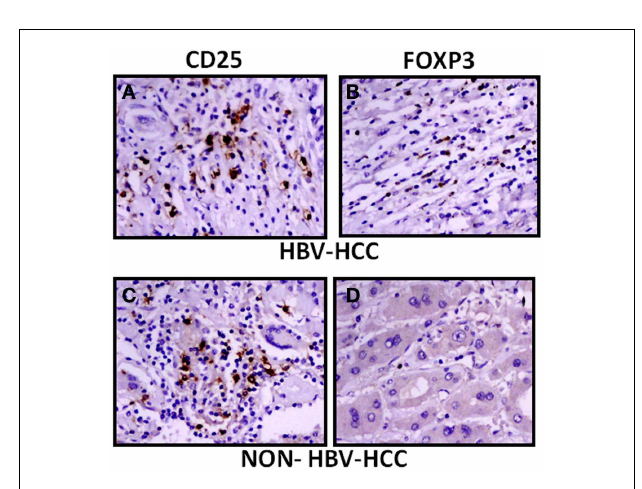
FIGURE 5 | Immunohistochemical analysis showed increased expression of CD25 and FoxP3 in HBV-HCC patients (A,B) than non-HBV-HCC patients (C,D), Magnification: 40 ×